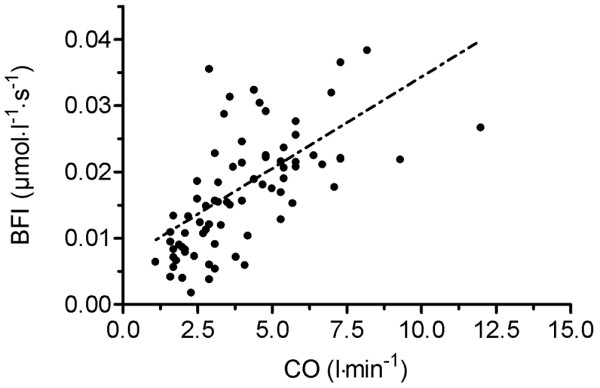
Correlation between cardiac output (CO) and blood flow index (BFI) by near infrared spectroscopy. r = 0.71; p < 0.0001. n = 76 measurements in 20 animals.